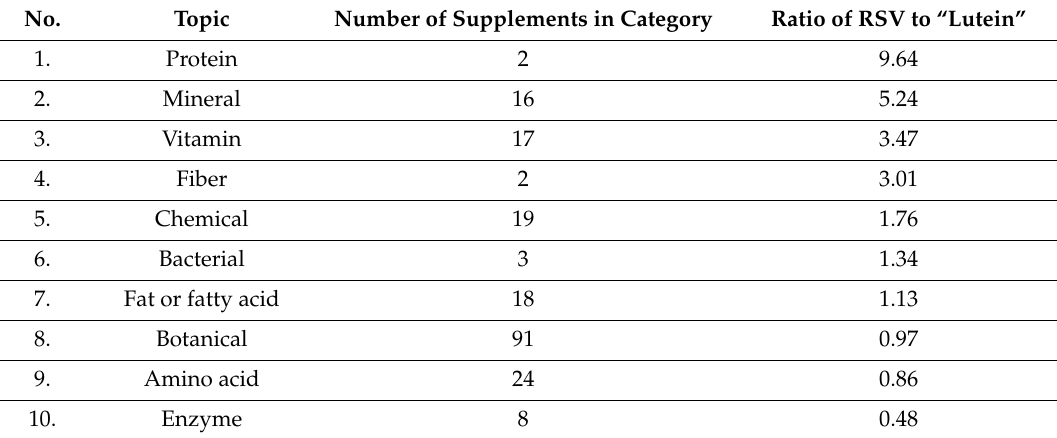
Table 1. Popularity of categories of supplement-related topics in proportion to “lutein” (adjusted data; relative search volume (RSV) over time).